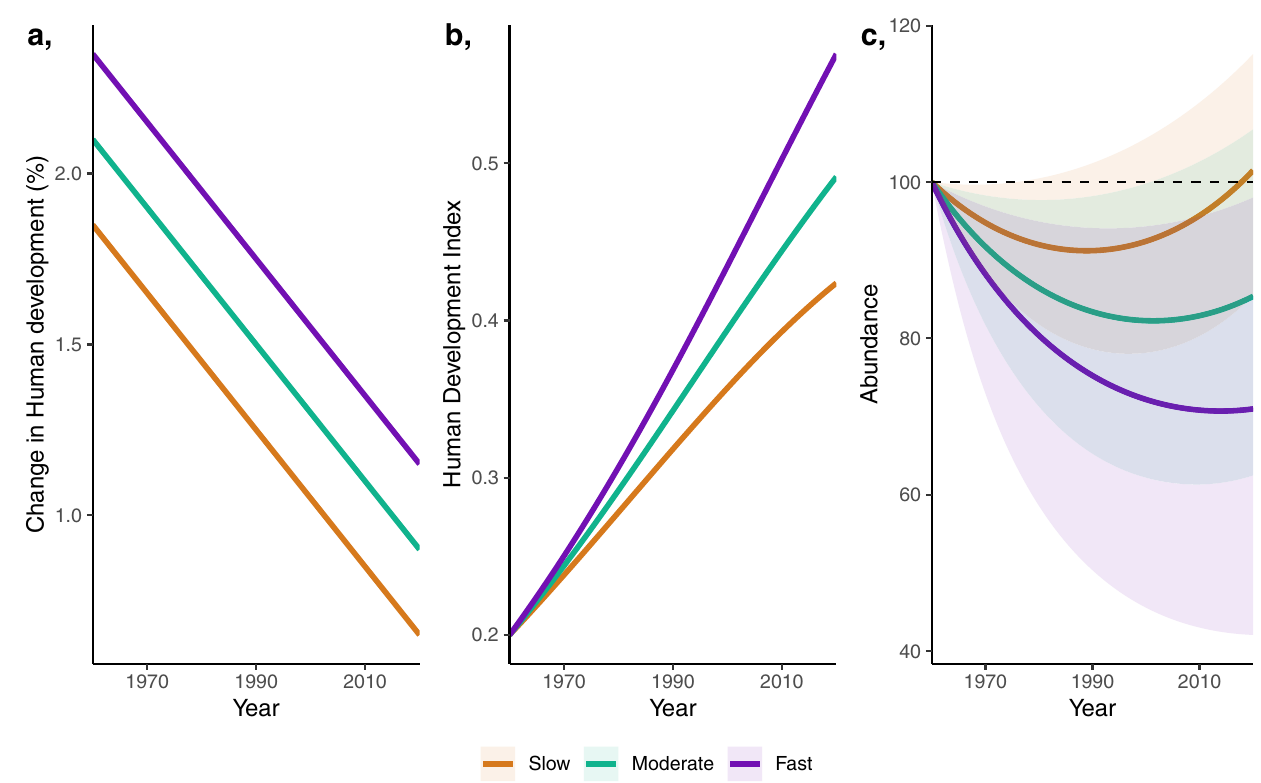
Fig. 5 | Projections of carnivore abundance vary with rate of change in human development.a InstantaneousChangeinHumandevelopment(asinthecovariate and parameter inFig. 3)over time under three pathways: Slow, Moderate and Fast. A key feature of the human development data is a deceleration in the human development growth rate as human development increases ( a and Supplementary Fig. 12a). b Projections of the Human development index (as in the covariate and parameter in Fig. 3) from a baseline of 0.2, derived using the three pathways of